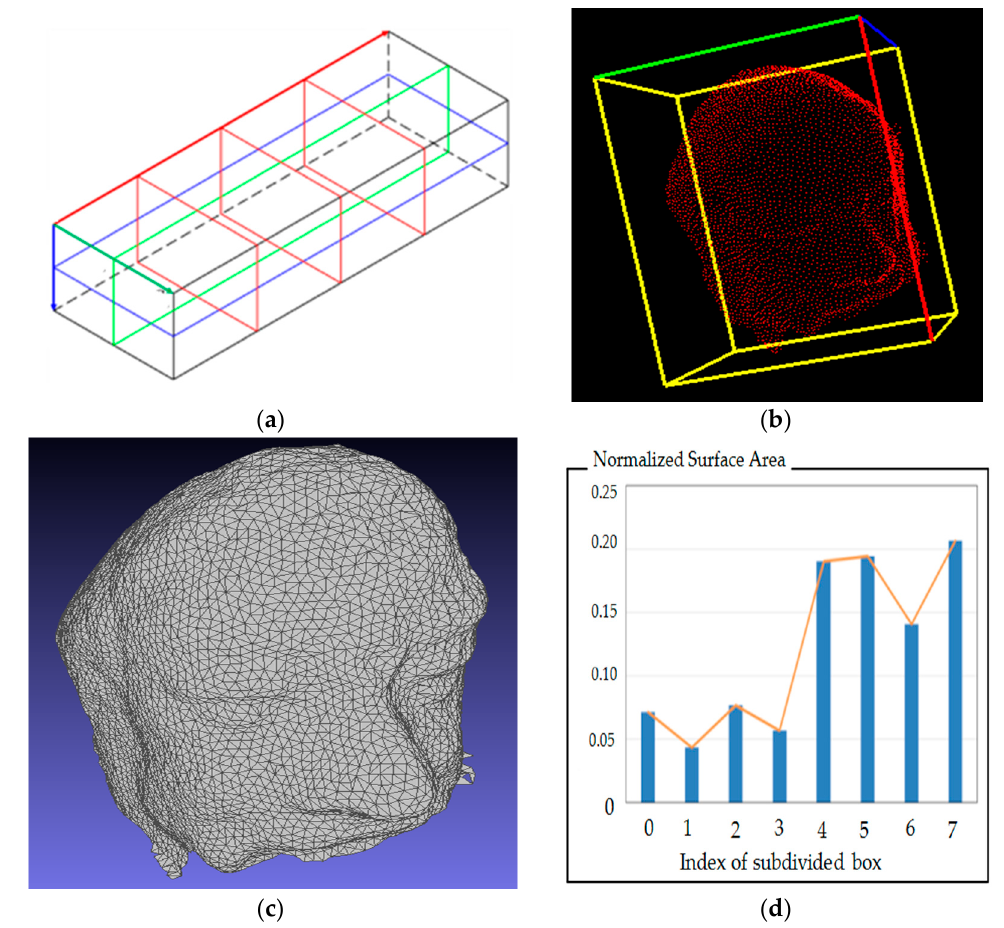
Figure 7. Illustration of the regional area ‐ based descriptor. ( a ) The OBB of the object is subdivided into smaller boxes; ( b ) The object point cloud and OBB; ( c ) Triangle mesh is generated over the point cloud data; ( d ) the regional area ‐ based descriptor of the object.